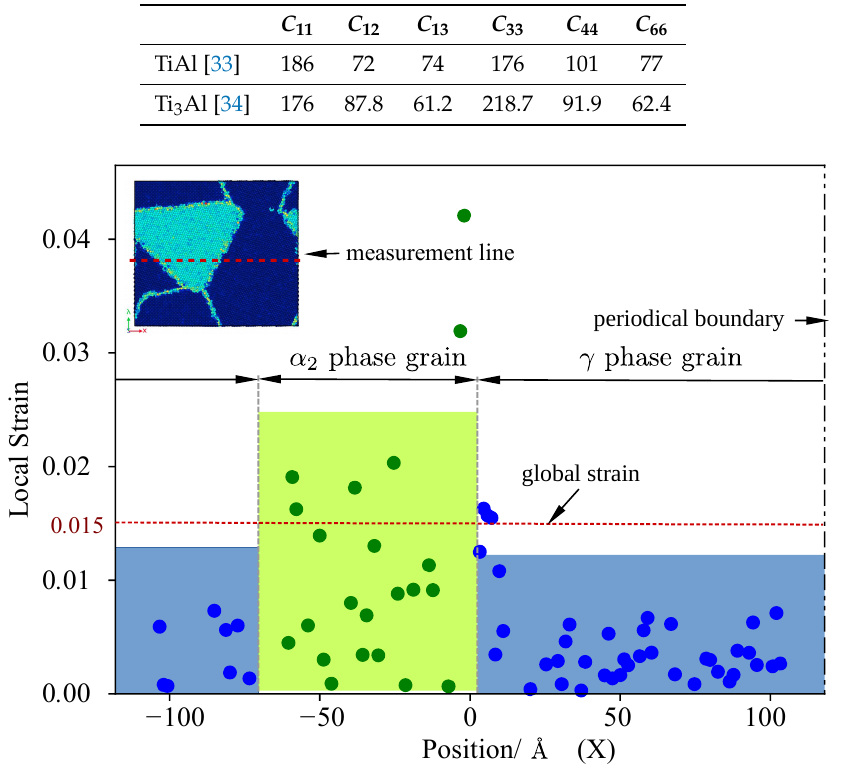
Table 3. Elastic constants of TiAl and Ti 3 Al.